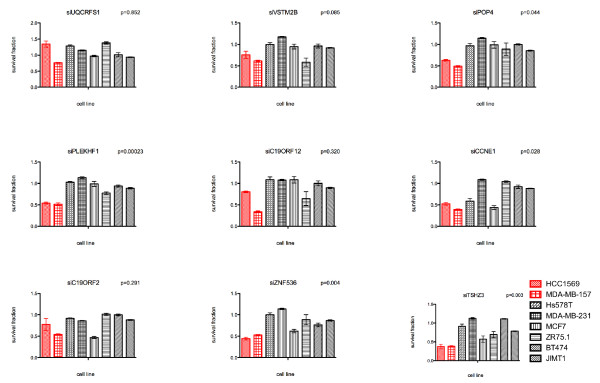
Impact of RNA interference silencing of genes mapping to the 19q12 amplicon on cell viability. Bar plots of the survival fraction relative to non-targeting siRNA control of breast cancer cells with (red) or without (black) 19q12 amplification upon transfection with short interfering RNA (siRNA) SMARTpools targeting UQCRFS1, VSTM2B, POP4, PLEKHF1, C19ORF12, CCNE1, C19ORF2, ZNF536 and TSHZ3. Cell viability was assessed after 10 days with CellTiter-Glo® cell viability assay. P-values of t-test of the survival fraction between cancer cells harbouring the amplification of the gene tested and those lacking its amplification (P
< 0.05 was considered significant). Error bars represent the standard error of the mean of three replicates.